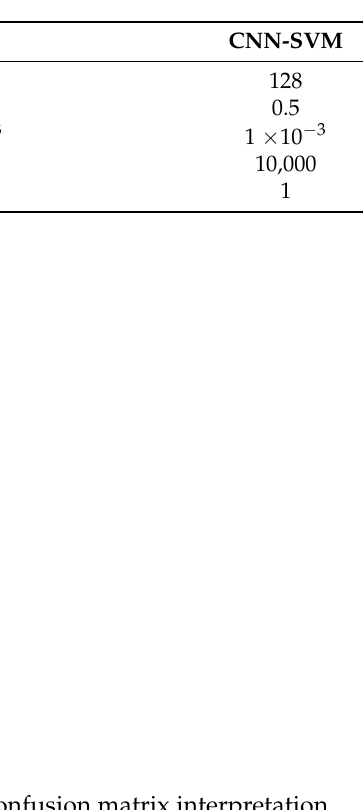
Table 5. Hyper-parameters used for CNN and CNN-SVM models.